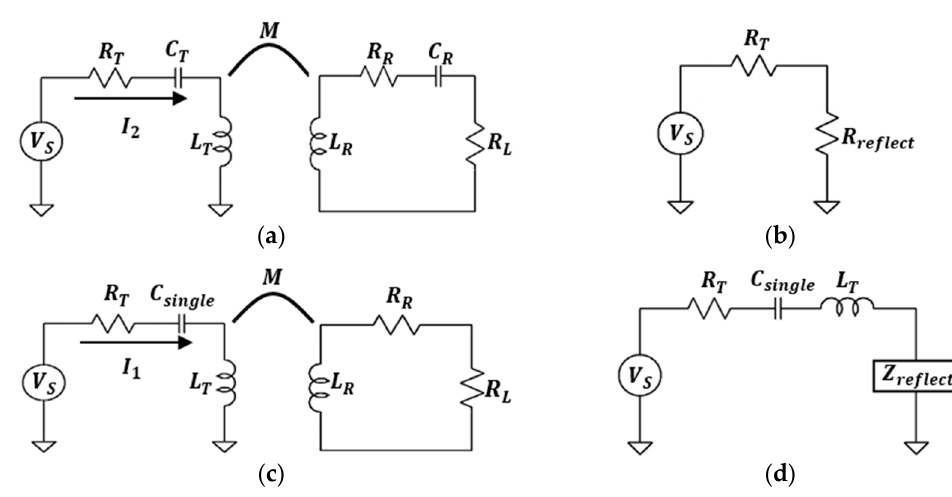
Figure 2. ( a ) Circuit model of series-series (SS) topology, ( b ) simplified equivalent SS circuit model, ( c ) circuit model of proposed series-none (SN) topology, and ( d ) equivalent SN circuit model using textile coil.